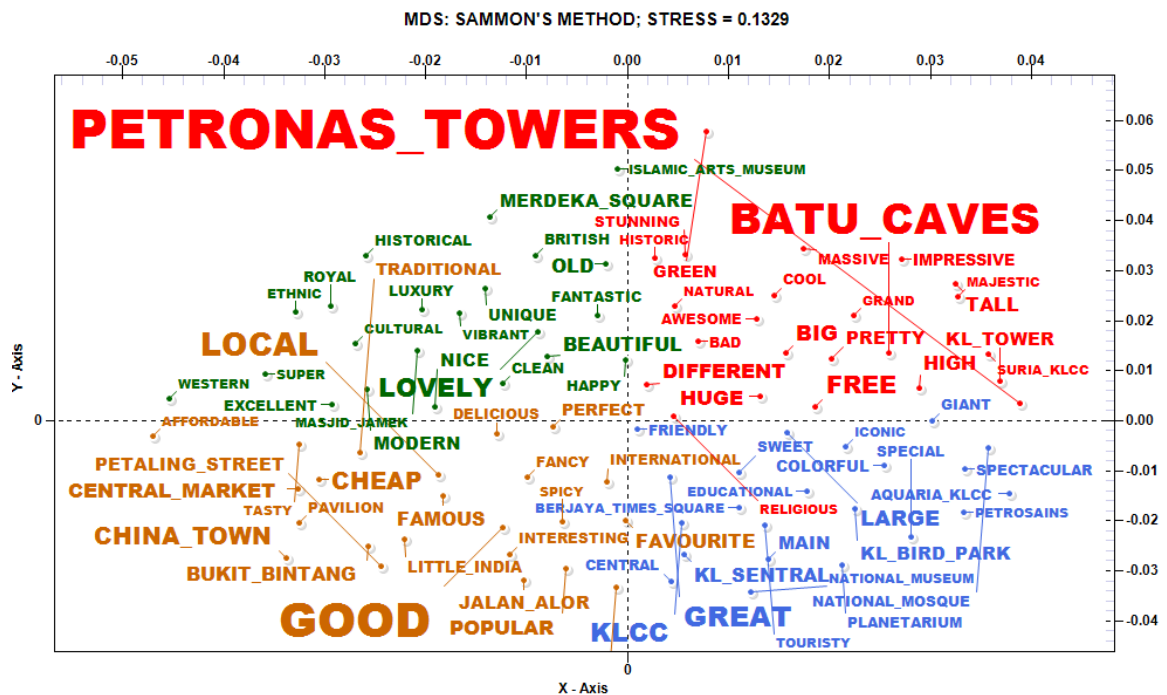
Figure 4. Dominant word MDS representation for POI–Qualifiers keywords.